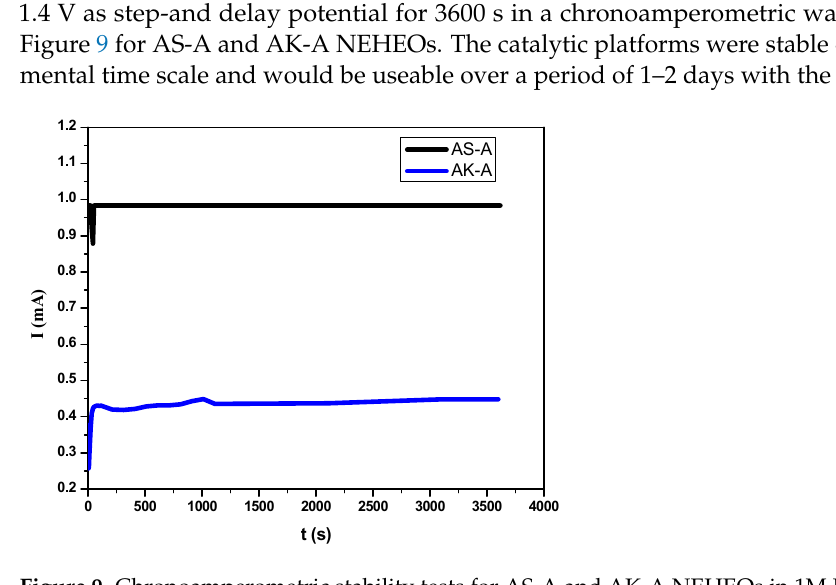
Figure 9. Chronoamperometric stability tests for AS-A and AK-A NEHEOs in 1M KOH for 3600